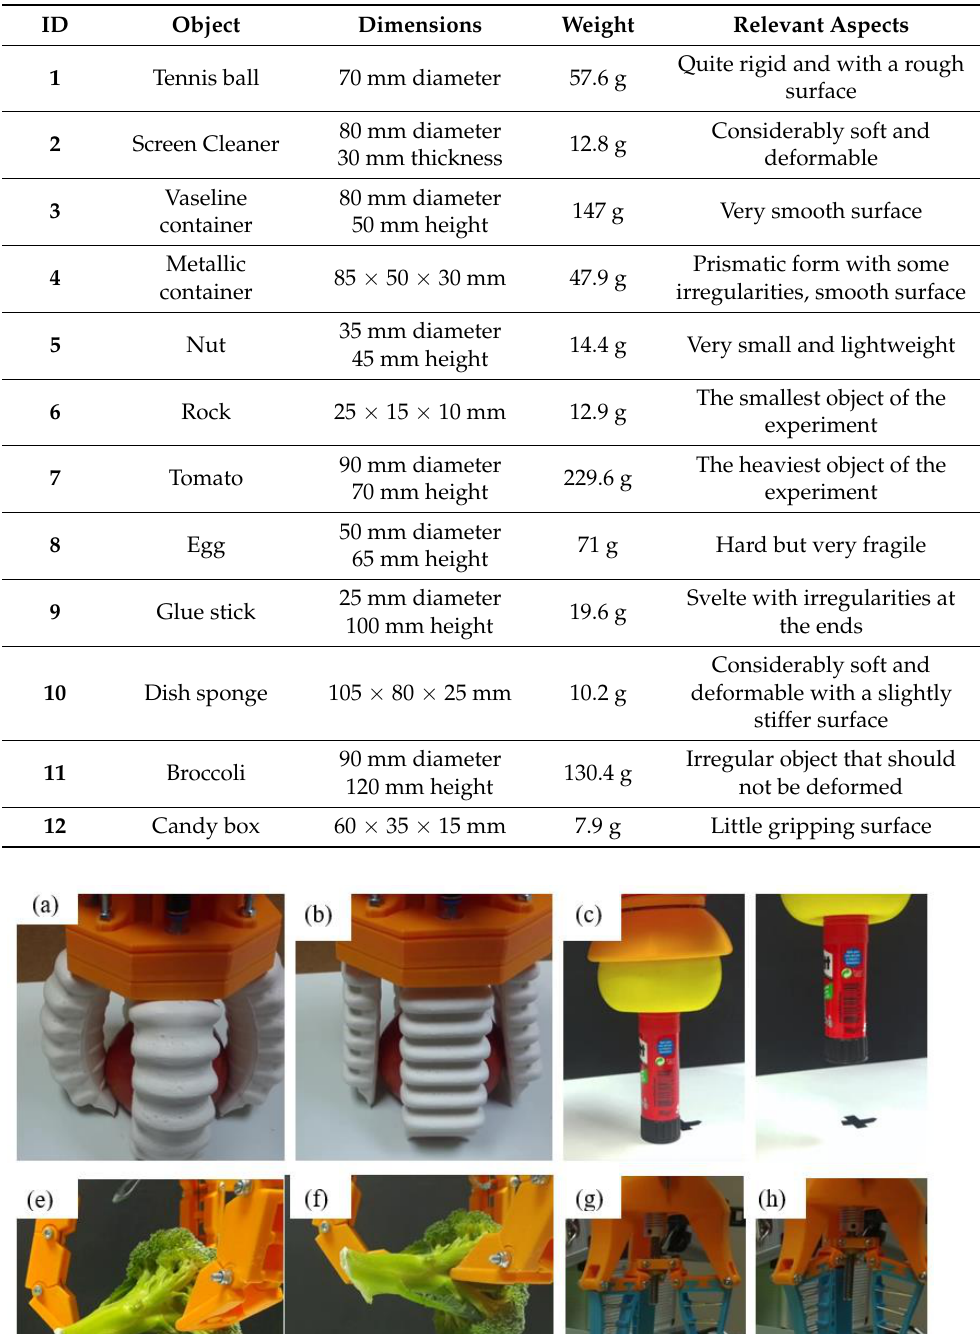
Table 1. Selection of objects for experimentation. Each object has been assigned a number to facilitate the subsequent display of results (first column). The “Dimensions” column shows the significant dimensions of each object, and the “Weight” column shows the weight of the objects used in the experiments. In the last column “Relevant Aspects”, the aspects that differentiate each object from the others are highlighted.